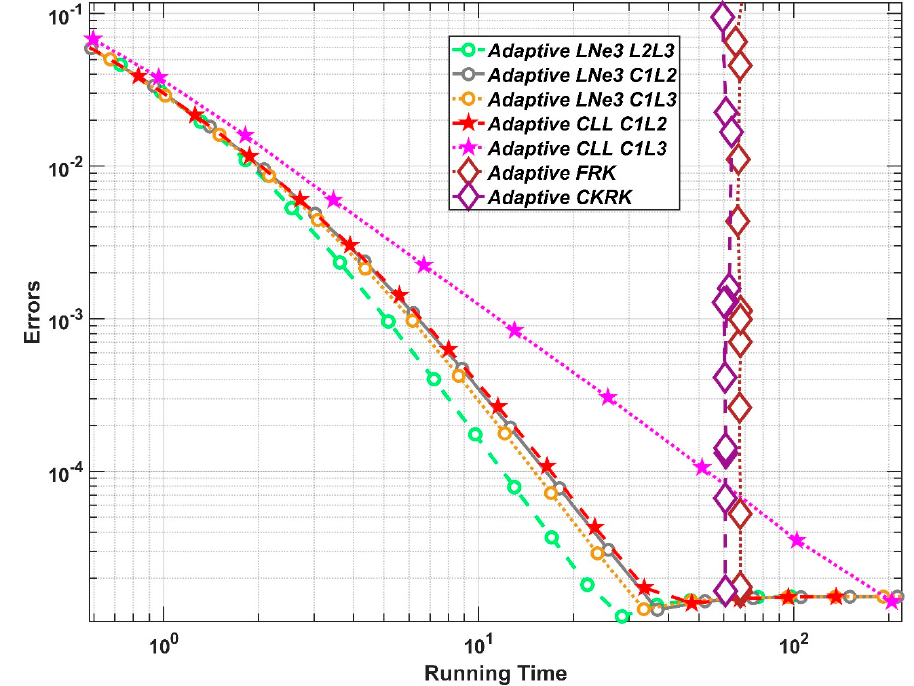
Figure 12. The 𝐿 (cid:2998) errors as a function of the running times in Experiment 2. Figure 12. The L ∞ errors as a function of the running times in Experiment We plo tt ed this limit as a function of time with a dashed blue line in Figure 13. At